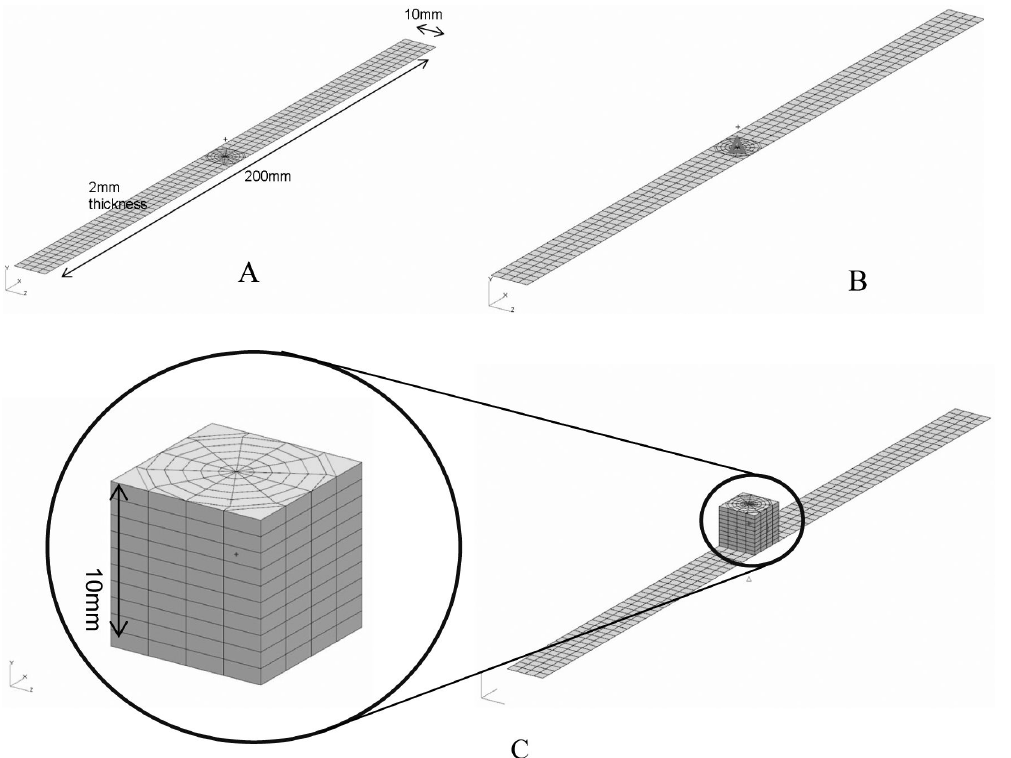
Fig. 11. (a) three cases of simply supported beam: A – Stand alone beam, B – Beam with a 1D TDA; (b) Three cases of simply supported beam: C – beam with 3D